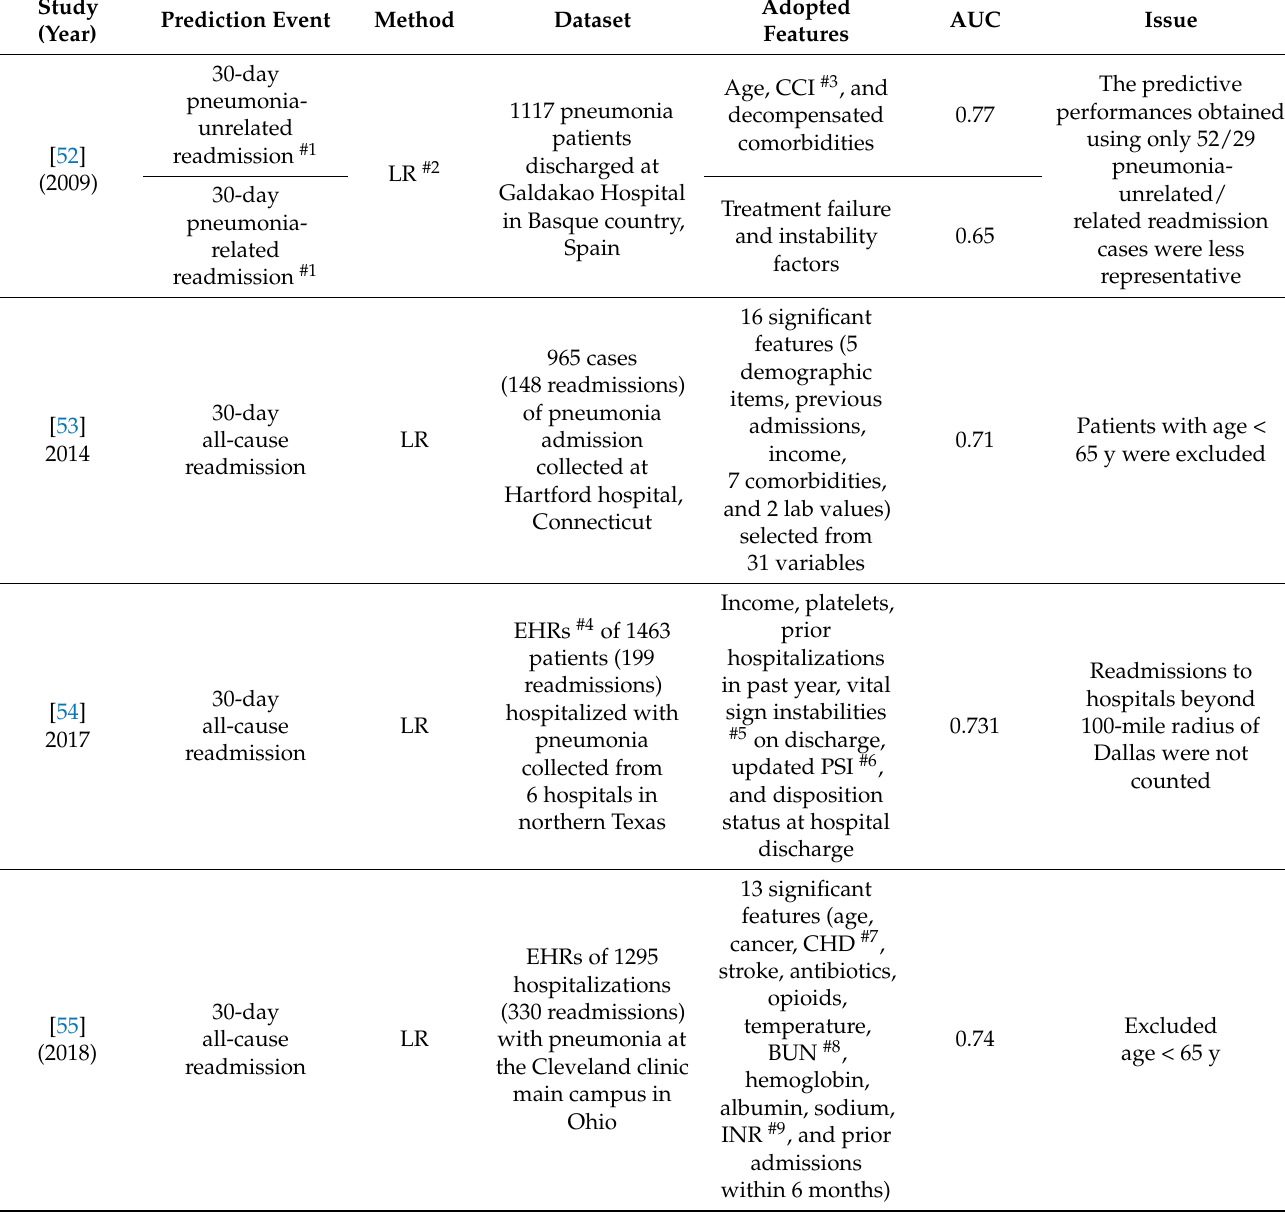
Table 3. Comparison of state-of-the-art studies in the prediction of readmissions for pneumonia